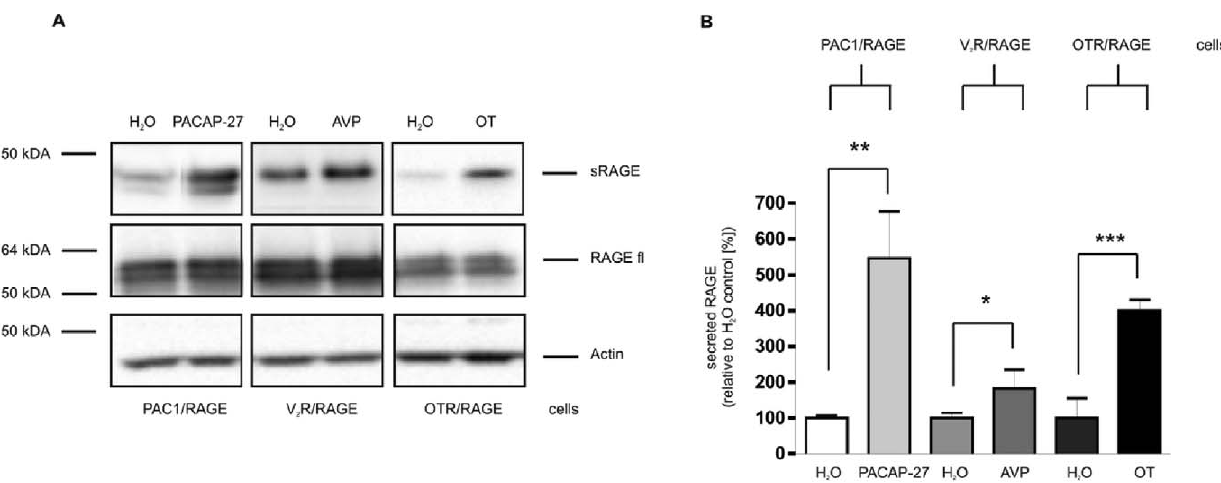
Figure 1. Stimulation of RAGE shedding via ligand-induced activation of different G protein-coupled receptors in HEK cells. The cell line co-expressing RAGE and the PAC1 receptor (PAC1/RAGE) was stimulated with PACAP-27, cells co-expressing RAGE and the V2 vasopressin receptor (V2R/RAGE) were treated with arginine-vasopressin (AVP) and cells co-expressing RAGE and the oxytocin receptor (OTR/RAGE) were stimulated with oxytocin (OT). As control, cell lines were mock-stimulated with comparable volumes of water. After stimulation with 300 nM of each hormone for 4 h the cell culture supernatant was collected and the proteins were precipitated. Secreted RAGE (sRAGE) was detected by Western blotting using the polyclonal antibody 3260, followed by an anti-rabbit antibody labeled with horseradish peroxidase and ECL. Full-length RAGE and actin were detected in cell lysates by Western blot analysis. For quantification the experiments were done in triplicates. (A) Western Blots for secreted RAGE (sRAGE) in cell culture supernatants, full-length RAGE (RAGE fl) and Actin in cell lysates. (B) Quantitative analysis: Shown are the mean effects 6 S.D., significance was determined by the One-way ANOVA Bonferroni test (* = P , 0.05; ** =0.01; *** = P , 0.001).